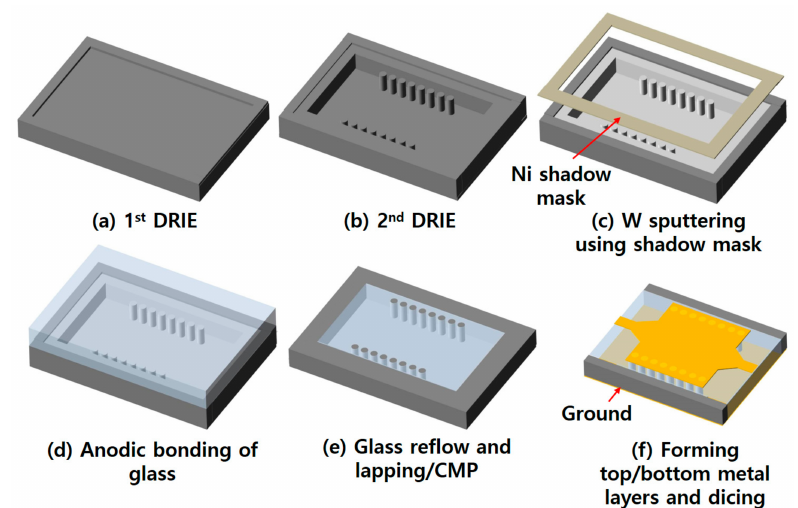
Figure 3. Fabrication process of the SIW with